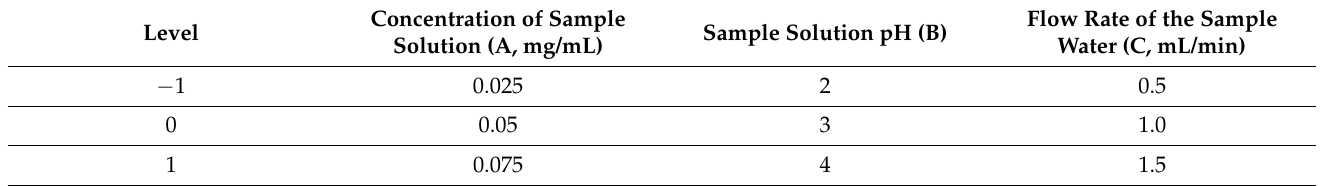
Table 6. Response surface test